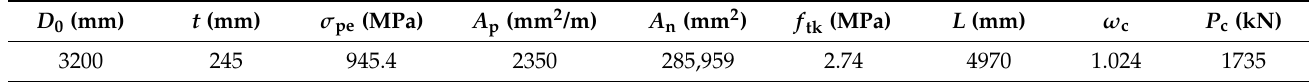
Table 4. Calculation results of P c .